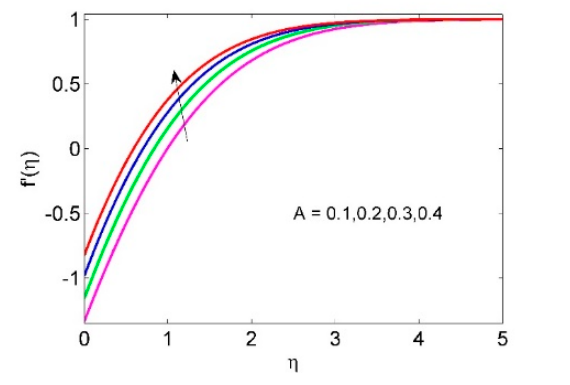
Figure 6. Impacts of A on 𝑓 ′ (𝜂) and 𝜃(𝜂) . Figure 7a witnessed that by raising the nanoparticle volume fraction of 𝜑 (cid:2870) up to 2%, the velocity profile diminishes. In general, an increase in the nanoparticle volume fraction causes resistance in the fluid flow, which slows down the velocity field. The temperature profile upsurges as increasing 𝜑 (cid:2870) up to 2% (see Figure 7b). In turn, this is due to the thermal conductivity of HNF elevates, and as a consequence fluid temperature rises.